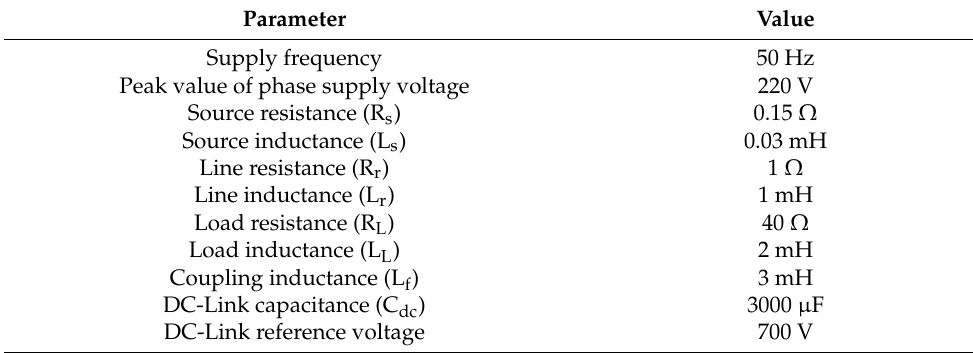
Table 1. Circuit